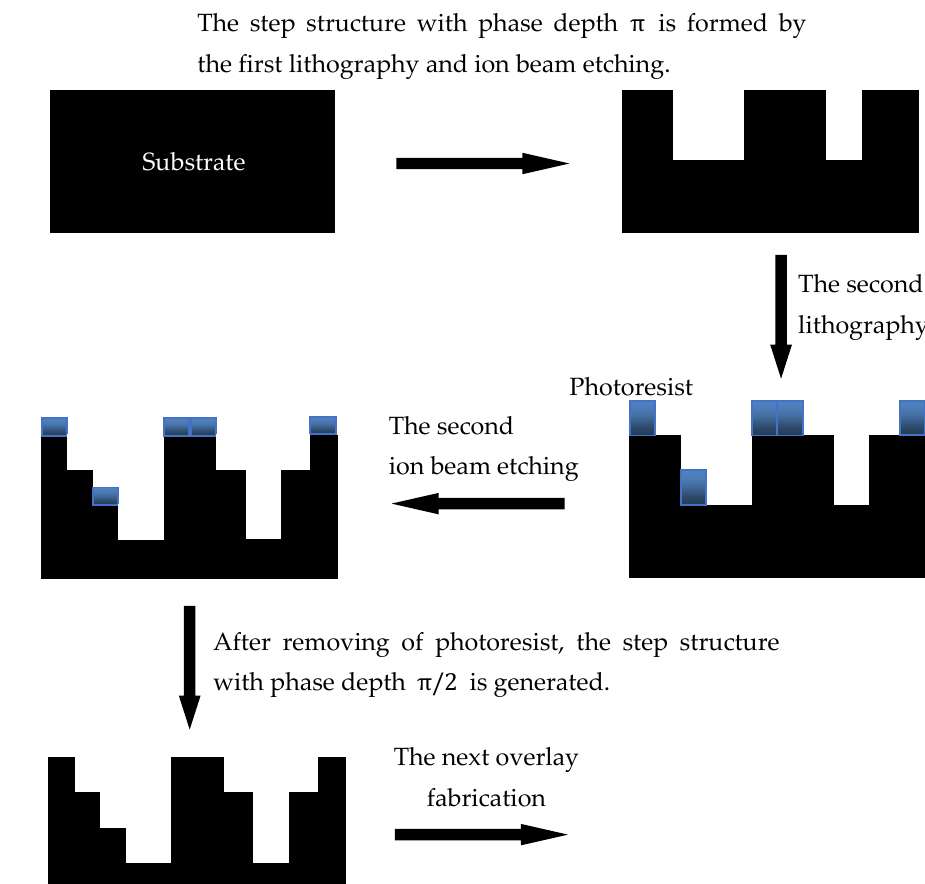
Figure 3. Schematic diagram of the DOE fabrication process.